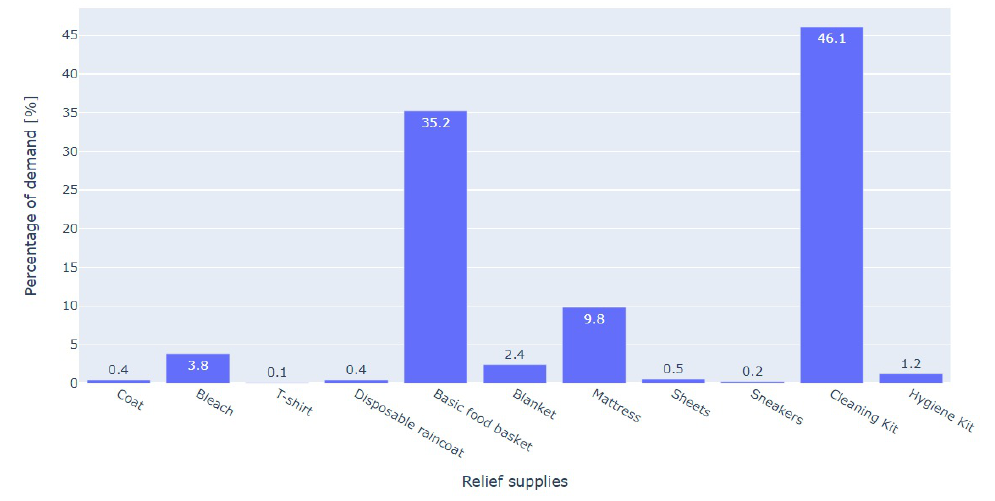
Figure 1. Composition of the demand by type of relief supply.